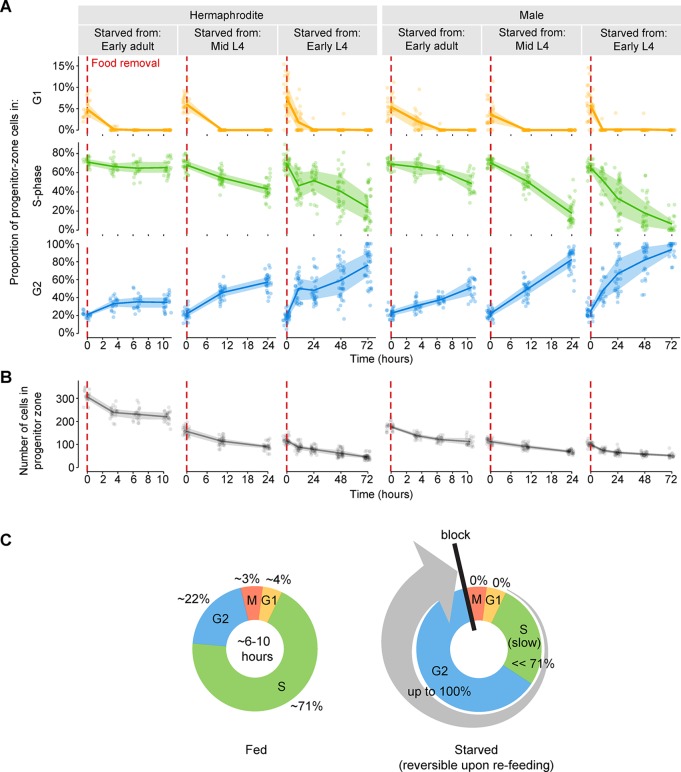
Starvation slows S-phase and causes germ cells to arrest in G2.(A) Time courses showing the proportion of progenitor-zone cells in G1, S-phase, or G2, for animals starved from early adult or from mid or early L4. Animals starved from mid L4 were adults at the 10.5- and 24-hr time points. Animals starved from early L4 were adults at the 24-, 48-, and 72-hr time points. n = 19–40 gonadal arms per time point. (B) Time courses showing the number of cells in the progenitor zone, for the same gonads used in A. Within each plot, lines connect means, and shaded areas show interquartile ranges. (C) Schematic summarizing the effect of starvation on the mitotic cell cycle of germ cells. Cell-cycle length under fed conditions was measured in adult hermaphrodites (Figure 3—figure supplement 1). Source data are available in Figure 3—source data 1.DOI:
http://dx.doi.org/10.7554/eLife.10832.00710.7554/eLife.10832.008Figure 3—source data 1.Counts of cells in each phase of the cell cycle for starvation time courses of wildtype animals.This comma-separated value file contains counts of progenitor-zone cells in each phase of the cell cycle for starvation time courses of wildtype animals (Figure 3). Each row of the file represents a single cell. Descriptors include cell-cycle phase (G1, S-phase, G2, M-phase), animal sex (hermaphrodite, male), age at the start of starvation (early L4, mid L4, early adult), time, and a gonad identifier.DOI:
http://dx.doi.org/10.7554/eLife.10832.00810.7554/eLife.10832.009Figure 3—source data 2.Counts of cells in each phase of the cell cycle for fed adult wildtype hermaphrodites.This comma-separated value file contains counts of progenitor-zone cells in each phase of the cell cycle for fed early adult hermaphrodites and fed hermaphrodites aged 24 hr post mid L4 (Figure 3—figure supplement 1A–B). Each set of four rows of the file represents a single progenitor zone. Descriptors include cell-cycle phase (G1, S-phase, G2, M-phase), age (early adult, L4 + 24h), and a gonad identifier.DOI:
http://dx.doi.org/10.7554/eLife.10832.00910.7554/eLife.10832.010Figure 3—source data 3.EdU labeling in fed adult wildtype hermaphrodites.This comma-separated value file contains counts of EdU-positive and EdU-negative M-phase cells in hermaphrodites exposed to EdU from the early adult stage or from 24 hr post mid L4 (Figure 3—figure supplement 1C). Each rows of the file represent a single time point. Descriptors indicate age at the start of EdU labeling (early adult, L4 + 24h).DOI:
http://dx.doi.org/10.7554/eLife.10832.01010.7554/eLife.10832.011Figure 3—source data 4.Propidium iodide intensities versus nuclear volume in the progenitor zone.This comma-separated value file contains propidium iodide intensities and nuclear volumes of interphase progenitor-zone nuclei and distal tip cell nuclei of six EdU-labeled gonadal arms (Figure 3—figure supplement 2). Gonadal arms are from fed early adult hermaphrodites or hermaphrodites starved from early adult for 3.5 hr. Each row of the file represents a single cell. Descriptors include treatment group (fed, starved), cell-cycle phase (G1, S-phase, G2, distal tip cell), and a gonad identifier.